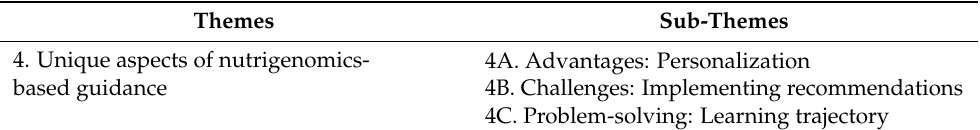
Table 2. Theme and sub-themes unique to Tx-GLB + Ngx 1 intervention